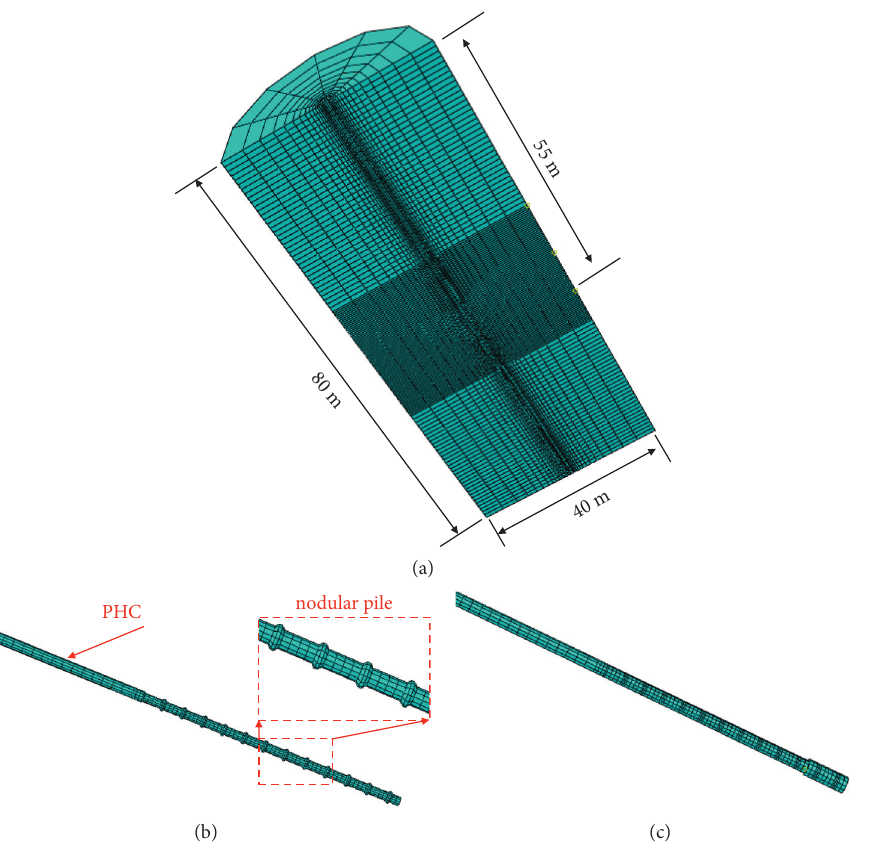
Figure 2: 3D finite element mesh. (a) Soil. (b) Precast pile. (c) Cement soil around the precast